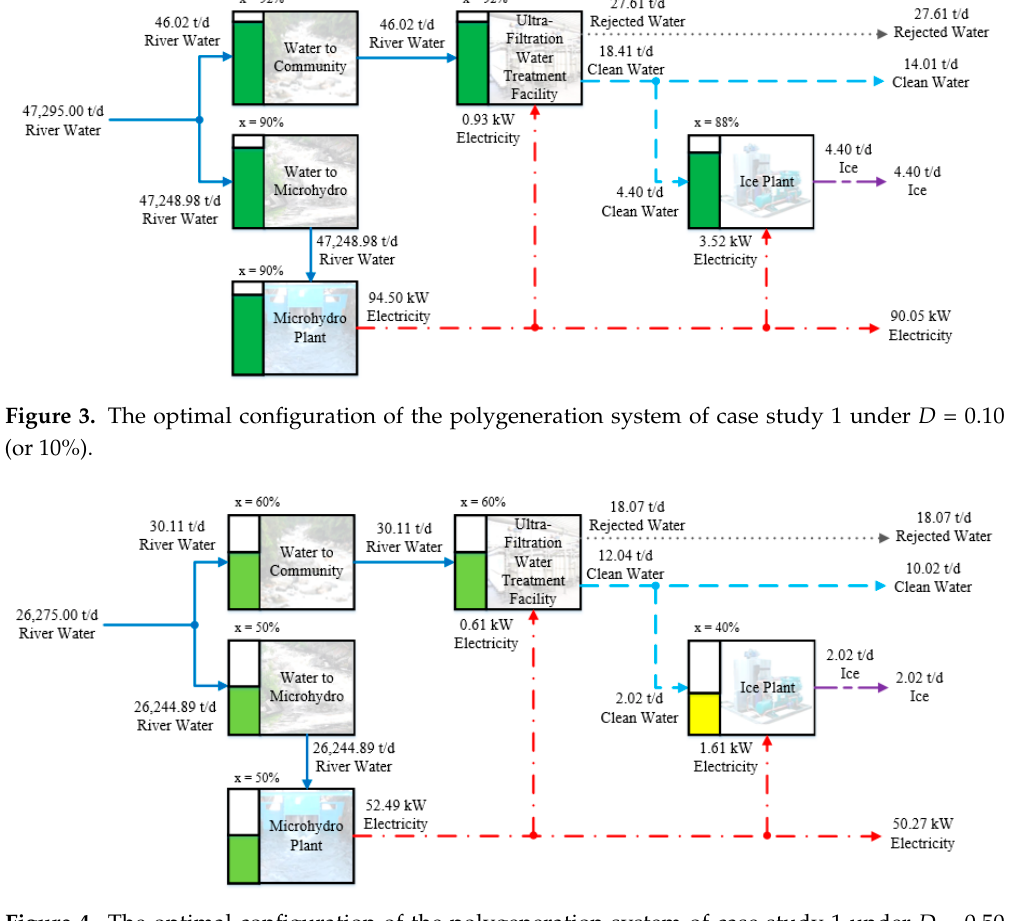
Table 3. The balanced process matrix of case study 2.